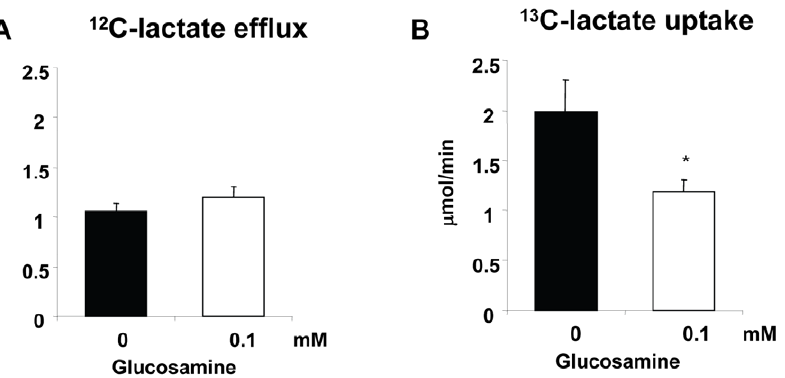
Figure 3. Effect of 0.1 mM glucosamine on A) unlabeled glycolytic lactate efflux and B) exogenous [3- 13 C]lactate uptake * P , 0.05 vs. 0 mM, Student’s t-test. 0 mM (n=4), 0.1 mM